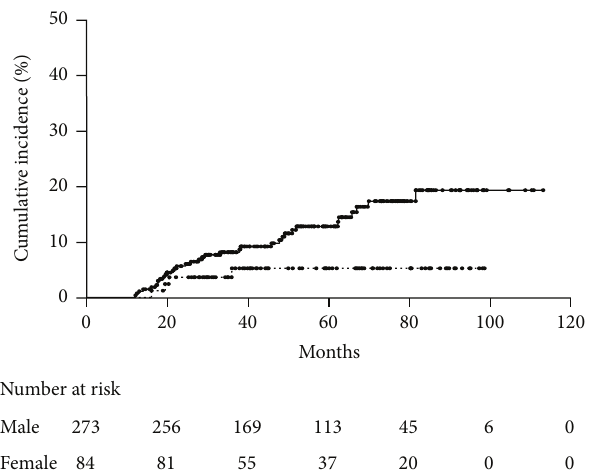
Figure 2: Cumulative incidence of metachronous tumors after ESD in male and female patients. The incidence of metachronous tumors was significantly greater among male patients (solid line) than among female patients (dotted line; 𝑃 = 0.04 ).